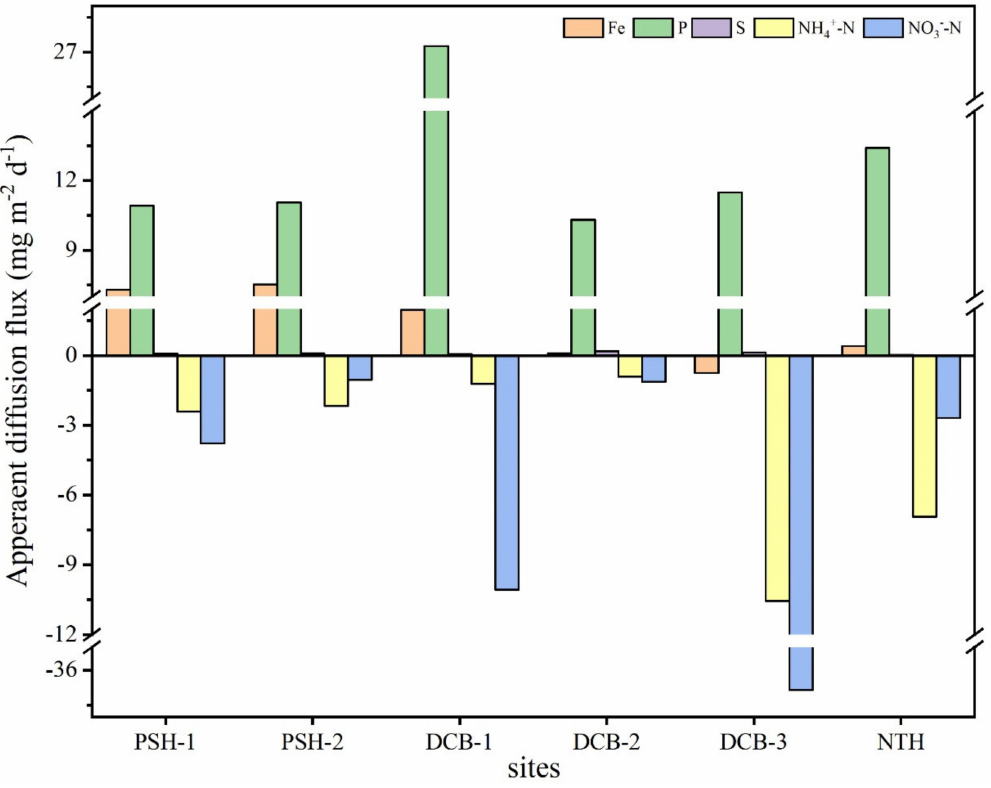
Figure 5. The apparent diffusion flux of the labile P, Fe, S, NH 4 + -N, and NO 3 − -N across the